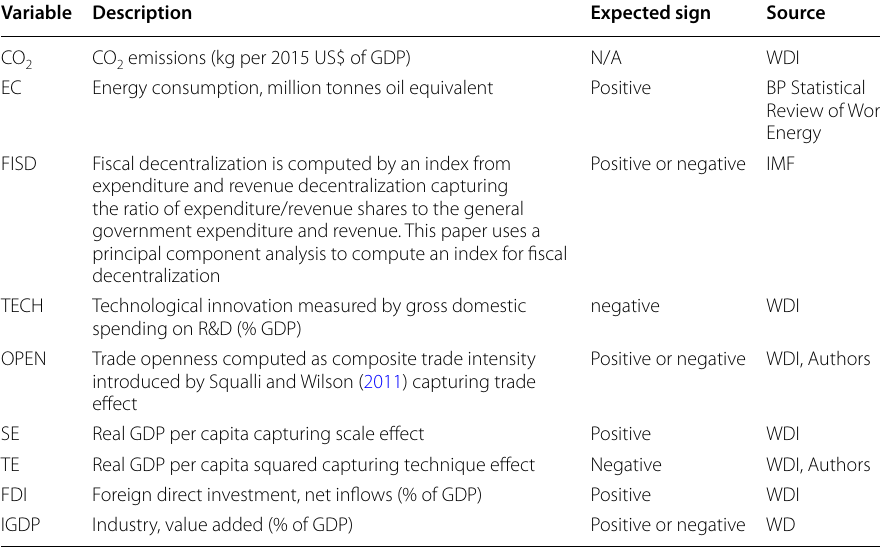
Table 2 Definition of variables and data sources Variable